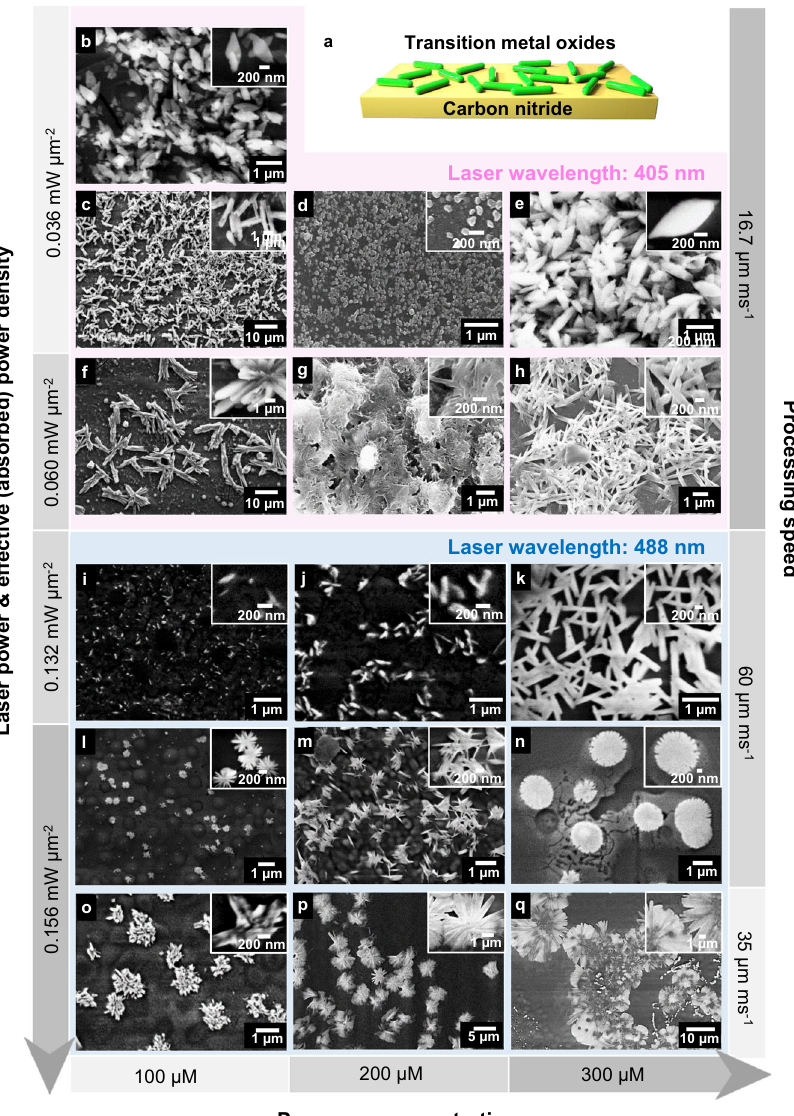
Fig. 4 SEM images of transition metal oxide (TMO) structures synthesized by LTRAS and their corresponding synthesis parameters. a Structure of TMO/CN composite fi lms. b , e , h – q CuO/CN. c , f NiO/CN. d , g